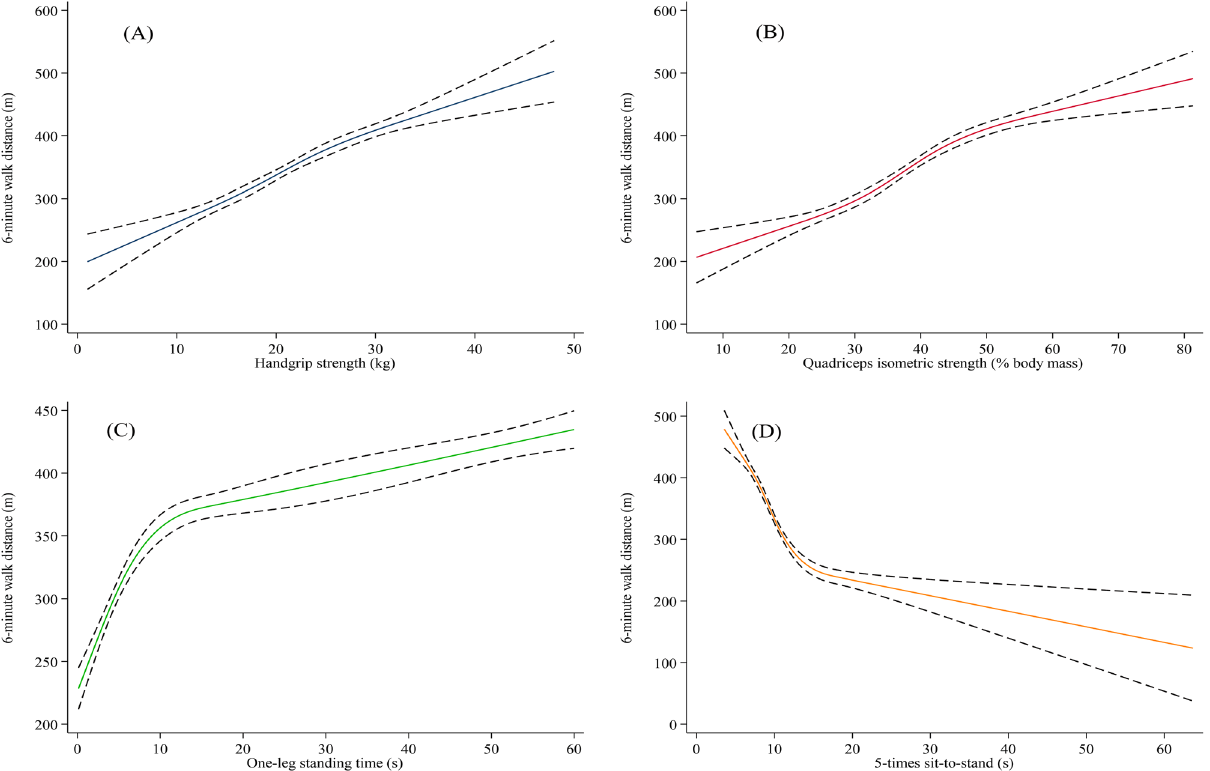
Figure 1. Associations of 6-minute walk distance with handgrip strength ( A ), quadriceps isometric strength ( B ), one-leg standing time ( C ), and 5-times sit-to-stand ( D ). Dotted lines indicate the 95% confidence